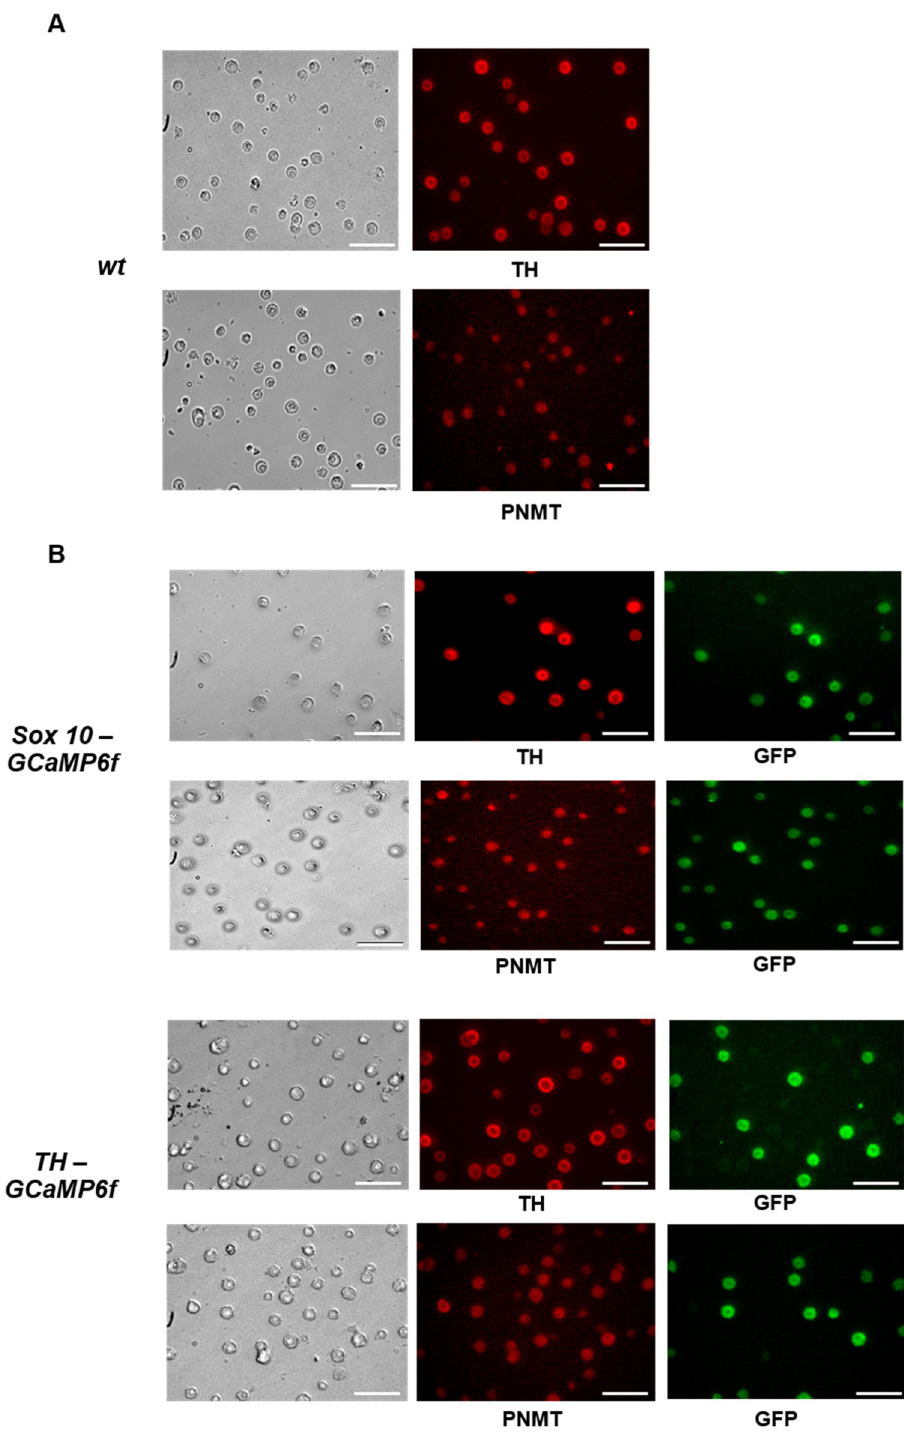
Fig 1. Comparison of cultured cells obtained from the adrenal medulla of wt , Sox10-GCaMP6f and TH-GCaMP mice. (A) Representative brightfield and fluorescence images of wt mouse ACC stained with antibodies against TH or PNMT. (B) Representative brightfield and fluorescence images of ACC derived from Sox10-GCaMP6f or TH-GCaMP6f mice stained with antibodies against TH and GFP, or PNMT and GFP. Scale bar = 100 μ m. Hoechst 33342 staining that was used to label nuclei to obtain the total number of cells in each field of view is not shown.